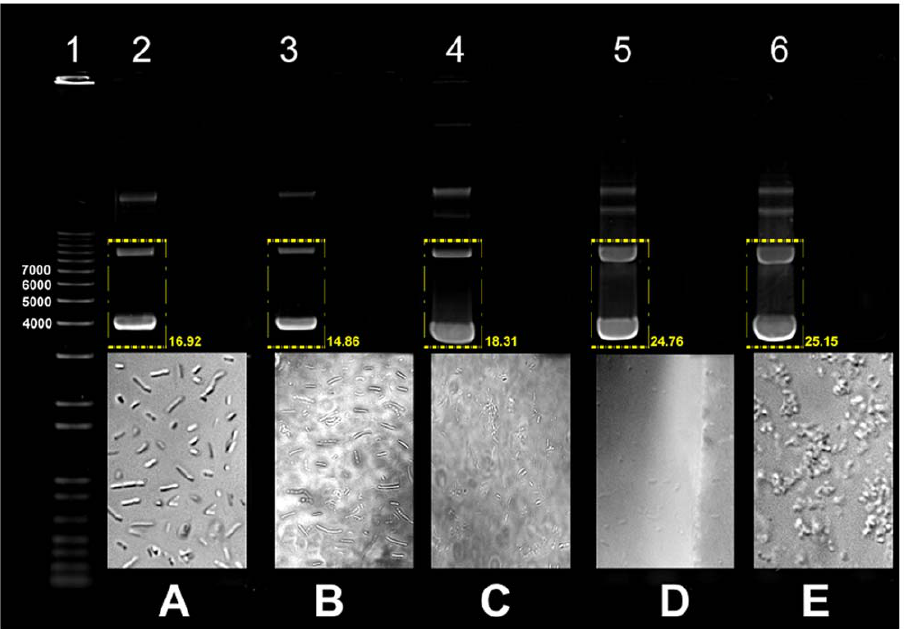
Figure 5. Plasmid DNA molecular forms and E.coli cell morphology after various isolation procedures. Plasmids were isolated from 2 ml XL1-Blue cultures containing multicopy plasmid B254, a pBluescript-based plasmid. Lane 1, 1 Kb Plus DNA ladder. Lane 2, isolation according to Godson and Sinsheimer using Brij-58. 15 m l DNA were loaded. Panel A shows corresponding E.coli cell morphology. Lane 3, isolation according to Clewell and Helinski using Brij-58 and DOX. In this and all following lanes 3 m l DNA were loaded. Panel B shows corresponding E.coli cell morphology. Lane 4, isolation according to Summerton et al. using Brij-58 and DOX in highly hypertonic salt-sucrose solutions. Panel C shows corresponding E.coli cell morphology. Lane 5, alkali isolation according to Birnboim and Doly. Panel D shows corresponding E.coli cell morphology. Lane 6, NID isolation. Panel E shows corresponding E.coli cell morphology. Densitometry analysis of plasmid DNA isolated with the different methods is reported.